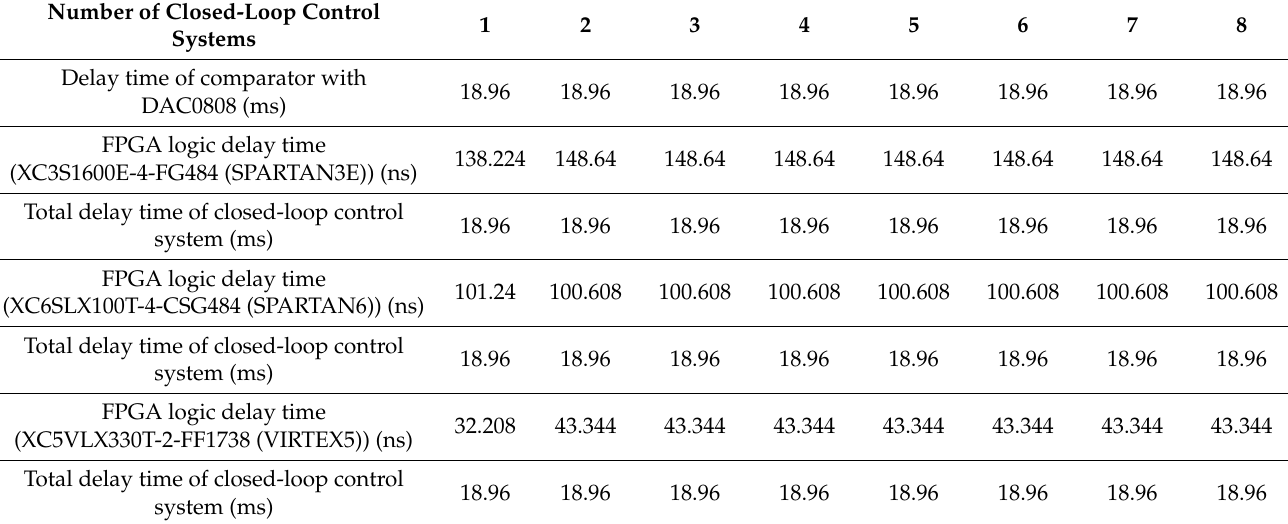
Table 5. Total delay time of multiple closed-loop control